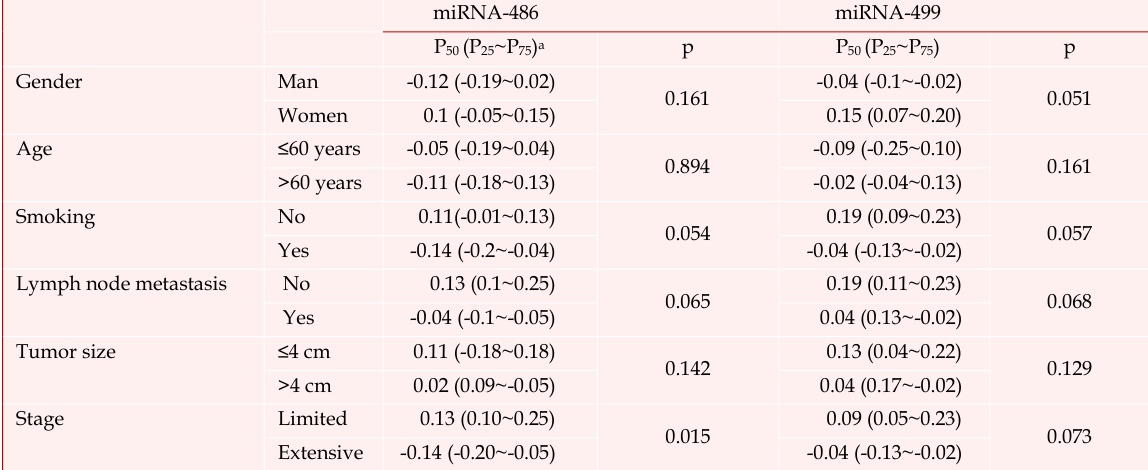
Relationship between the expression of the miRNA-486 and miRNA-499 in the plasma of SCLC with clinico- pathologic features of lung